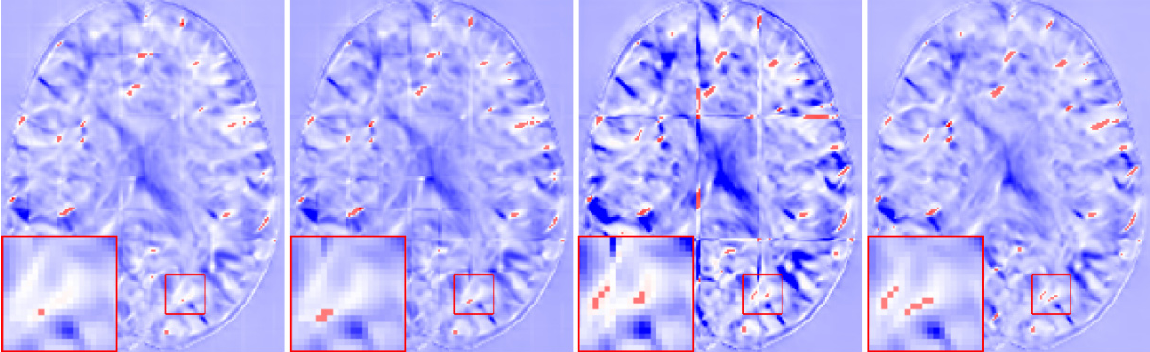
φ − < − < are marked in are marked in